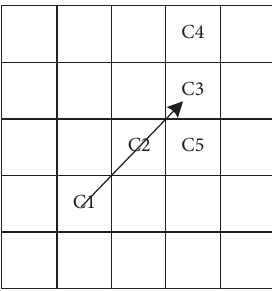
Figure 3: Schematic diagram of local optimal peak extraction.